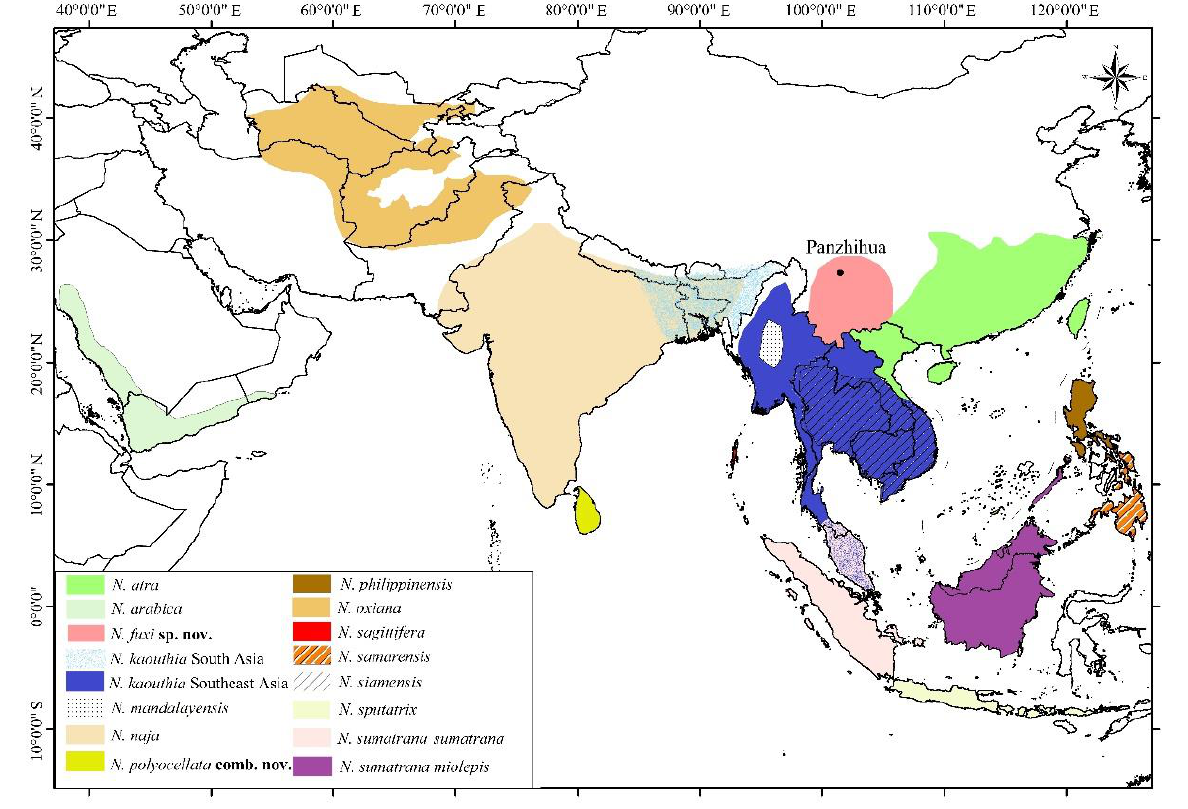
Figure 1. Distributions of cobras in Asia. Distribution data were adjusted from IUCN https://www.iucnredlist.org (accessed on 26 October 2020).